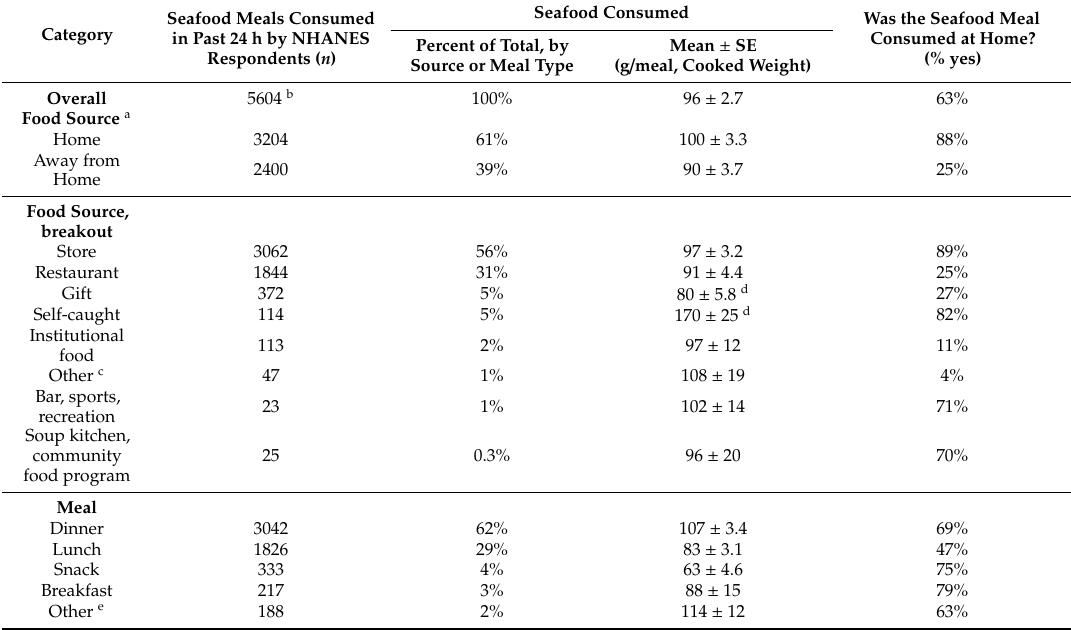
Table 2. Meal type, food source, and location of meal in United States adult seafood consumers ( ≥ 19) in the past 24 h (NHANES 2007 to 2016).